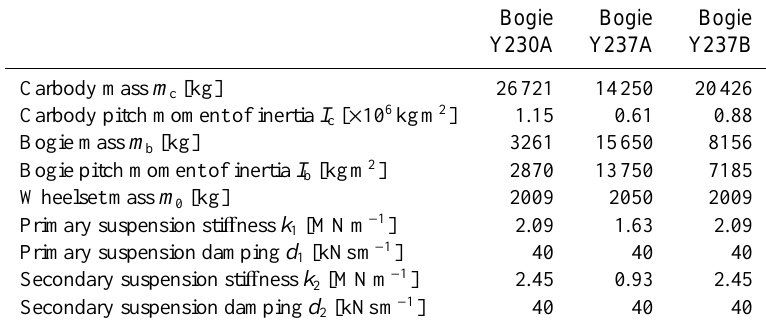
Figure 12. Studied multibody models for the vehicle. Table 1. Dynamic parameters of Thalys HST – unladen weight